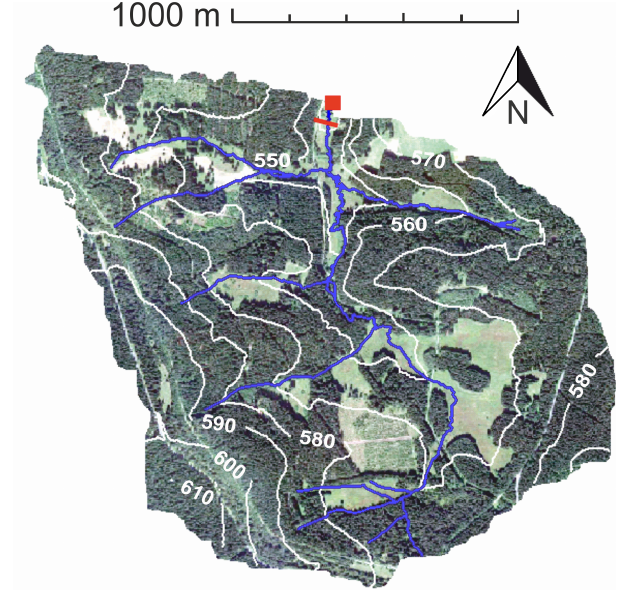
Figure 1. Topography of the Rappbode catchment with the UV-vis and discharge measurements at the outlet (red square). Transect for soil samples indicated by red line. Map data: ©Google, GeoBasis-